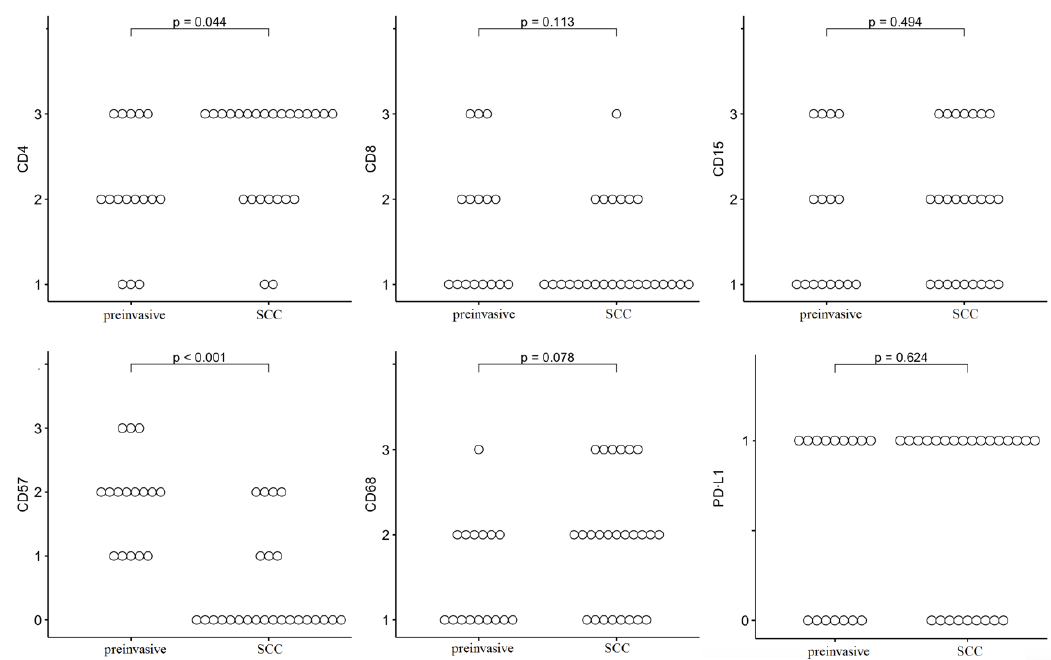
Figure 3. Representative images of immunohistochemical stains scored as 0 (( A ); CD57, larynx SCC), 1 (( B ); CD8, tongue preinvasive lesion), 2 (( C ); CD15, tongue SCC) and 3 (( D ); CD4, larynx SCC) and of PD-L1 ( E , F ), graded as low (0, < 1, ( E ), larynx preinvasive lesion) and high (1, ≥ 1, ( F ), tongue SCC). Bars: 100 µm.